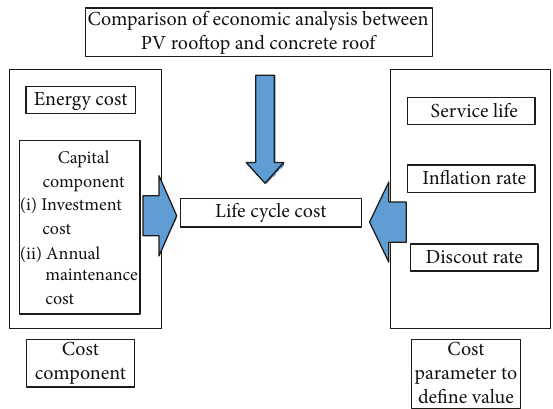
Figure 4: Analysis approach.